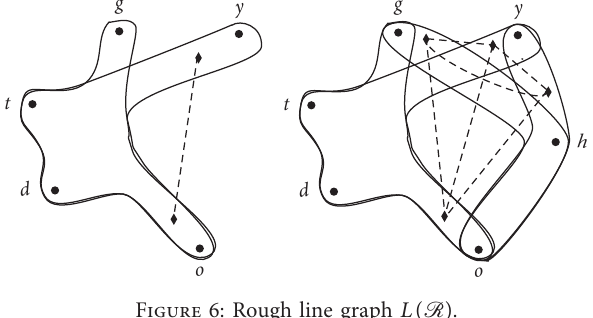
Figure 6: Rough line graph L ( R )